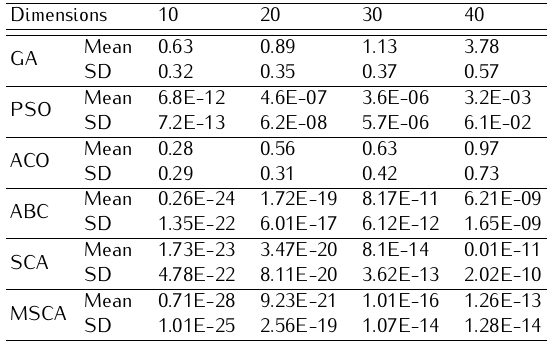
Table A.3. The results of GA, PSO, ACO, ABC, SCA and MSCA for Ackley function.